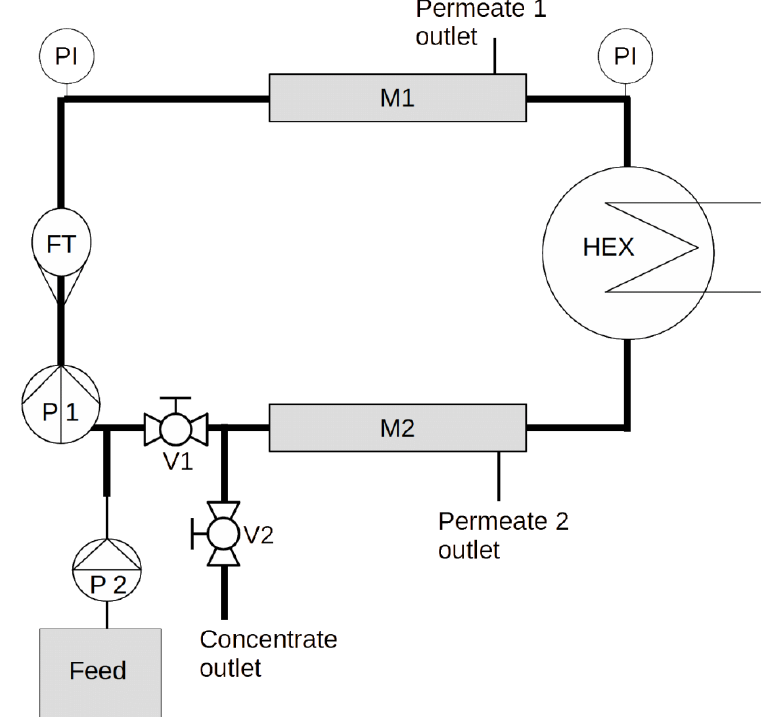
Figure 1. Closed-circuit small pilot experimental setup (legend in text).